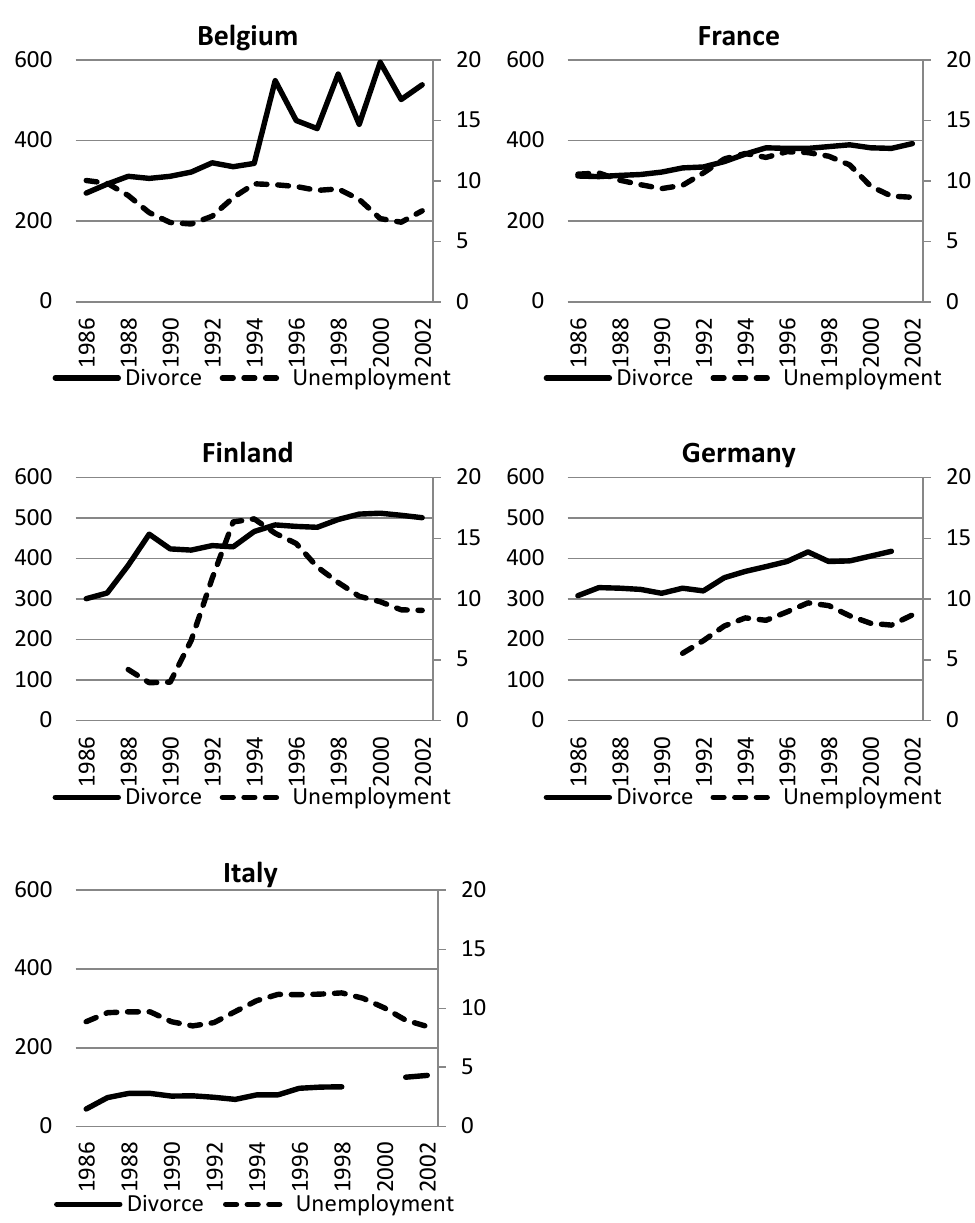
Figure 4 : Macroeconomic trends in unemployment and crude divorce rates by country